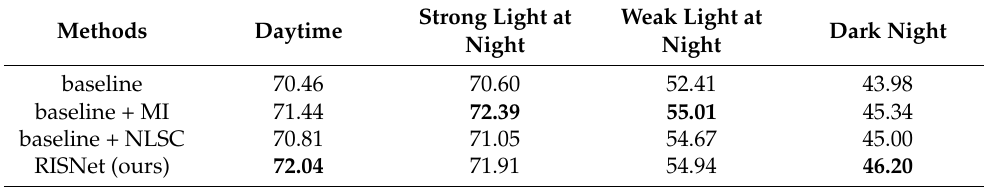
Table 4. Ablation experiments on the DroneVehicle remote sensing dataset under different lighting conditions, where the baseline is MBNet [31], MI represents the mutual information module, and NLSC represents the new lighting condition classification method. The best AP indicators are generally black.